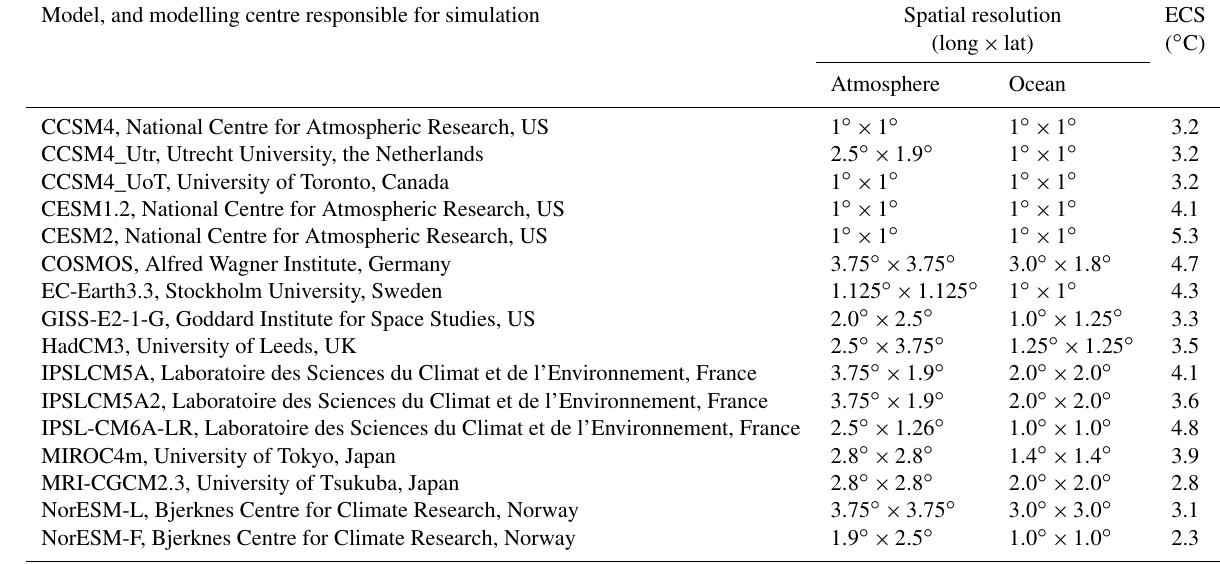
Table 4. Climate models included here from PlioMIP2 (see Haywood et al., 2020 for each model’s reference). Model, and modelling centre responsible for